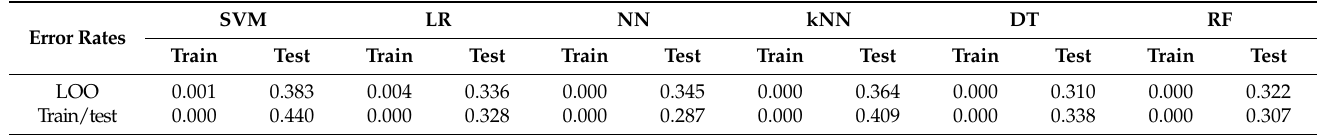
Table 6. Error rates for the BigD data set (default values).